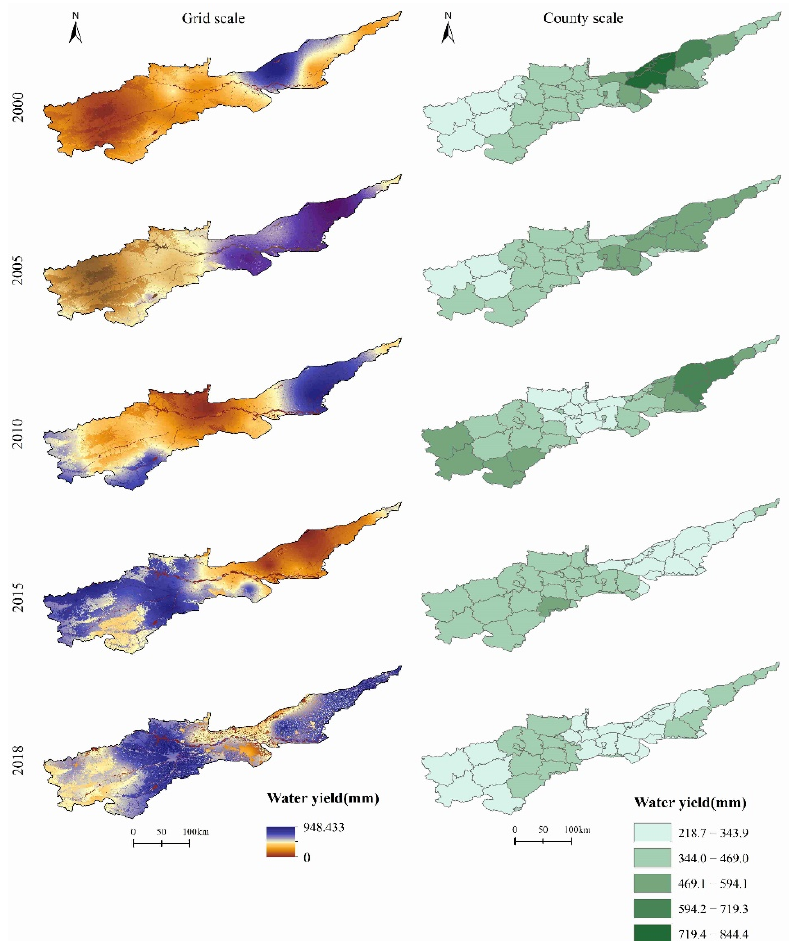
Figure 5. Spatiotemporal distribution patterns of water yield in the AYRHP on raster and county scales.